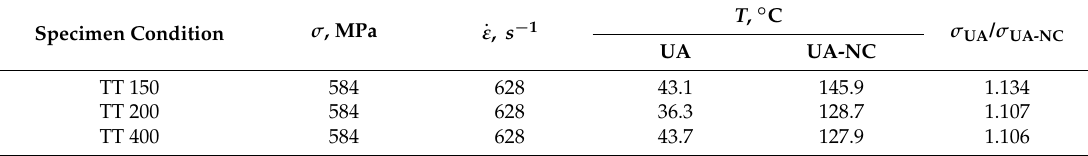
Table 3. Values of experimental data for UA and UA-NC specimens and results of σ UA / σ UA-NC . Specimen Condition